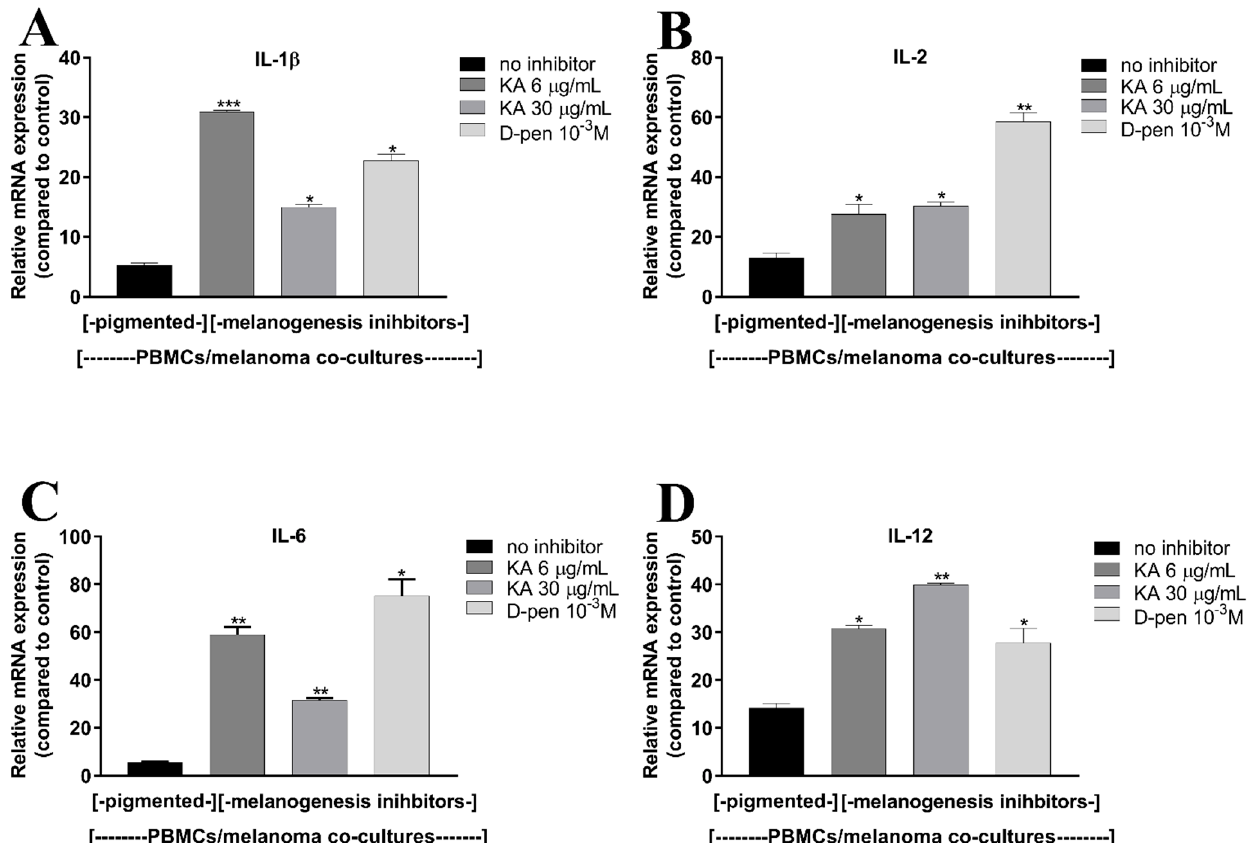
Figure 5. Inhibition of melanogenesis by D -pen or KA in melanoma cells affects the cytokine expression in co-cultured PBMCs. Pigmented melanoma cells were exposed to D -pen (10 − 3 M) or KA (6 or 30 µ g/mL) for 72 h, then seeded on inserts with 0.4 µ m pores. PBMCs were seeded in 24-well plates and activated with LPS (100 ng/mL); ( A – D ) the effect of melanogenesis inhibition in melanoma cells on IL-1 β ( A ), IL-2 ( B ), IL-6 ( C ), and IL-12 ( D ) mRNA expression in co-cultured PBMCs determined by RT-qPCR. Asterisks indicate significant differences in mRNA expression of cytokines between PBMCs co-cultured with pigmented cells and depigmented ones (* p < 0.05, ** p < 0.01, *** p < 0.001). Abbreviations: PBMCs— peripheral blood mononuclear cells; D -pen— D -penicillamine 10 − 3 M; KA—Kojic acid 6- or 30 µ g/mL;